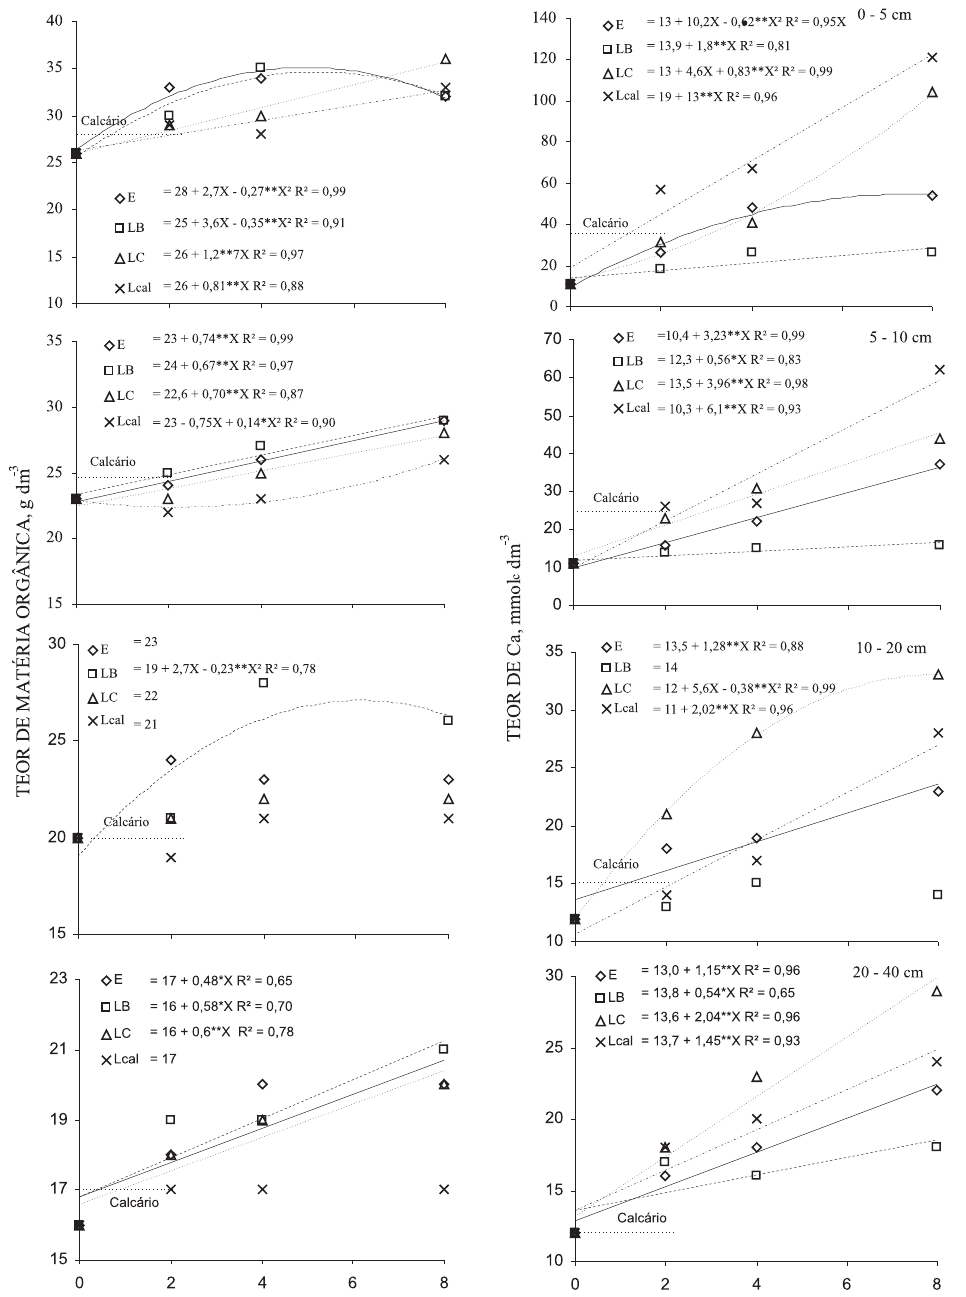
Figura 2. Teor de matéria orgânica e de cálcio no solo em função da aplicação dos resíduos e calcário aos 27 meses após a aplicação. As siglas E, LB, LC e Lcal são escória de aciaria, lodo de esgoto de biodigestor, lodo de esgoto centrifugado e lama cal,